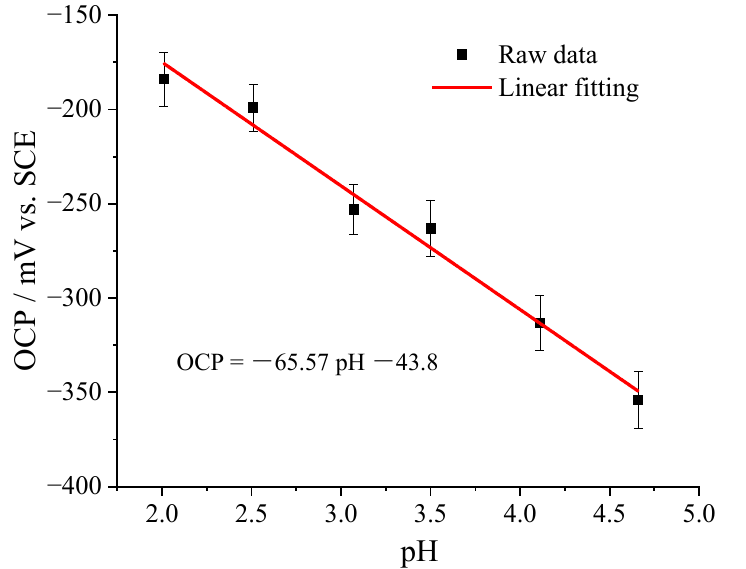
Figure 3. Plots of open circuit potentials and pH of the deionized water with adding 5% H 2 SO 4 and 5% NaOH droplets as functioned as “OCP = − 65.57 pH—43.8”.